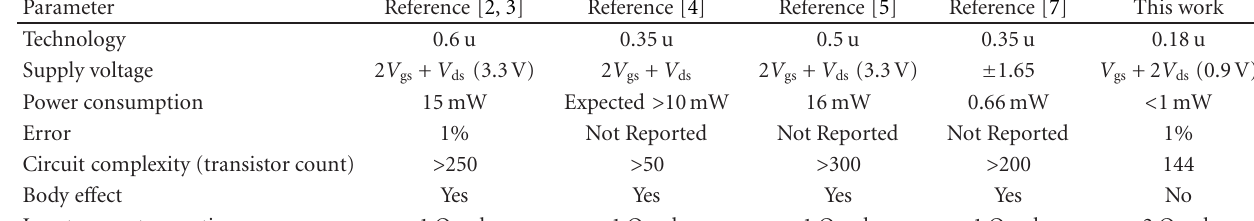
Table 2: Comparison with former classifier circuits.